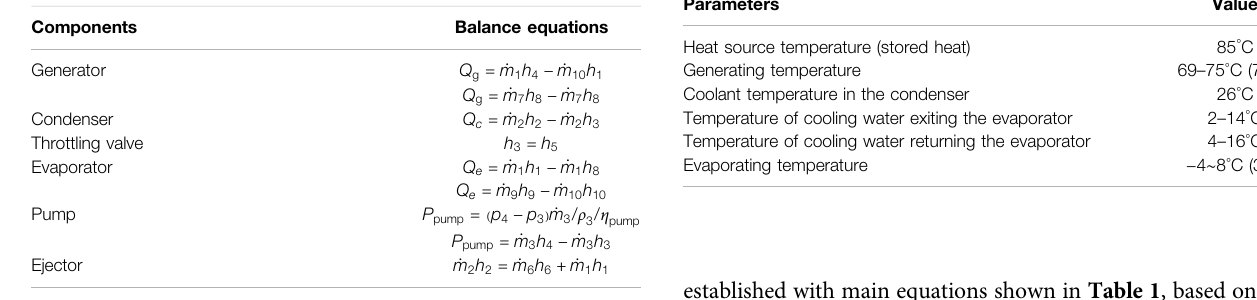
TABLE 1 | Energy and mass balance equations for components of the cooling system. Components Balance equations